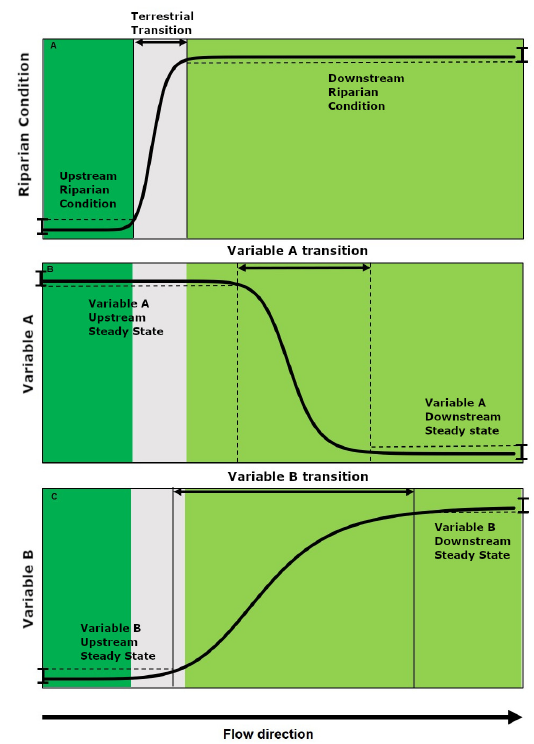
Figure 1. Expected behavior of two potential variables (panel B and C) in response to the change in riparian condition (panel A). The dark green area indicates the stable riparian condition upstream, the grey area indicates the terrestrial transition in riparian vegetation from the upstream to the downstream condition, and the light green area indicates the stable downstream riparian condition. Panel B and C show the potential responses of two different variables to the changes in the terrestrial riparian condition, transitioning from the upstream steady state to the downstream steady state. The variable in panel B shows a much faster response to the changes in riparian conditions, reaching the downstream steady state at a shorter distance compared to the variable shown in panel C. The variable in panel B also shows a delayed response compared to the variable in panel C.